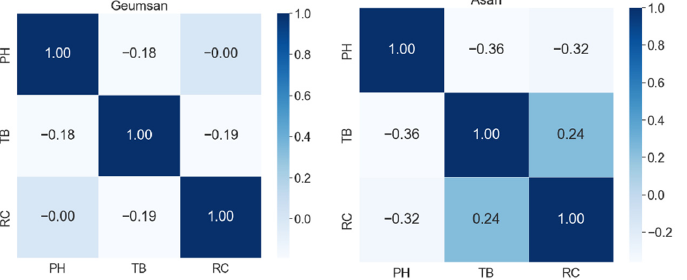
Figure 4. Spearman correlation coefficients for drinking water quality in the Han River basin.